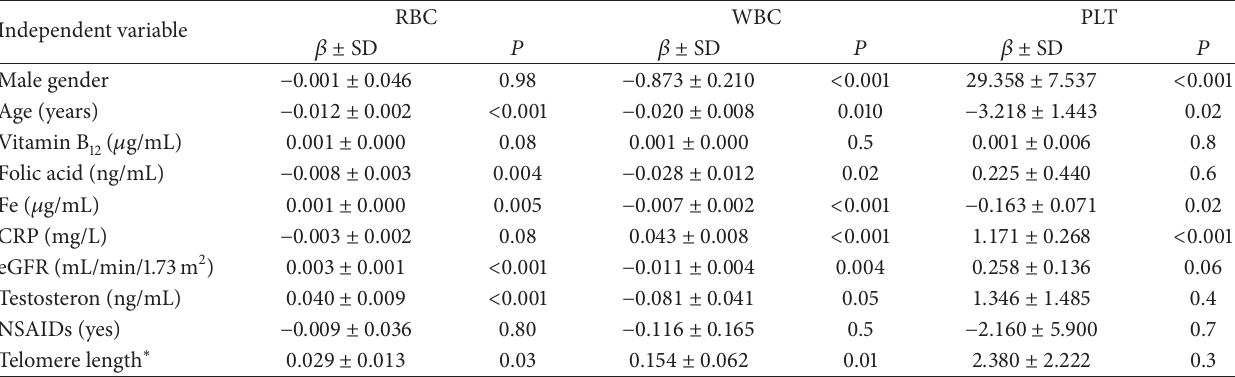
Table 4: Correlations between telomere length and red blood count (RBC), white blood count (WBC), and platelet count (PLT): results of multivariate analysis (linear regression model). 𝑅 2 = 0.16 for RBC model, 𝑅 2 = 0.07 for WBC model, and 𝑅 2 = 0.06 for PLT